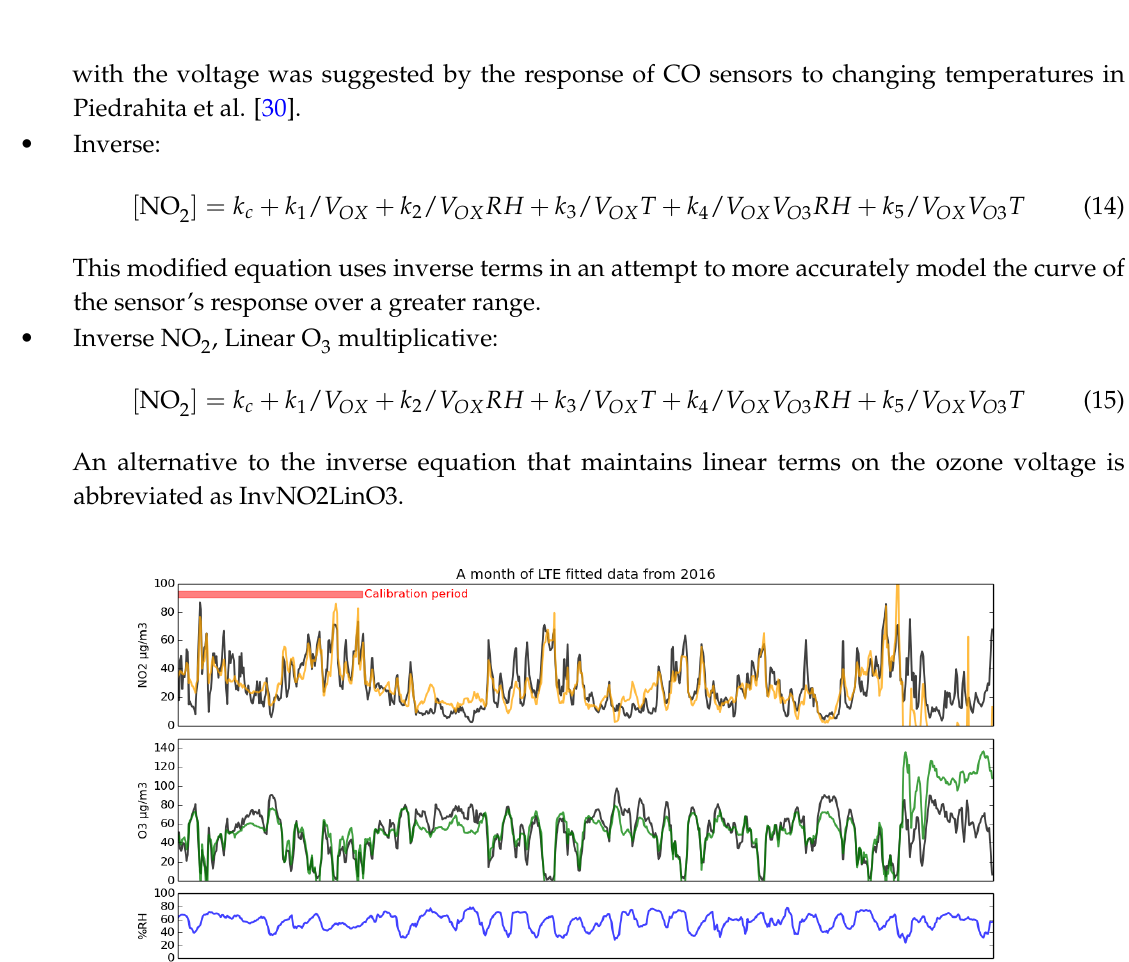
(orange) and O 2 3